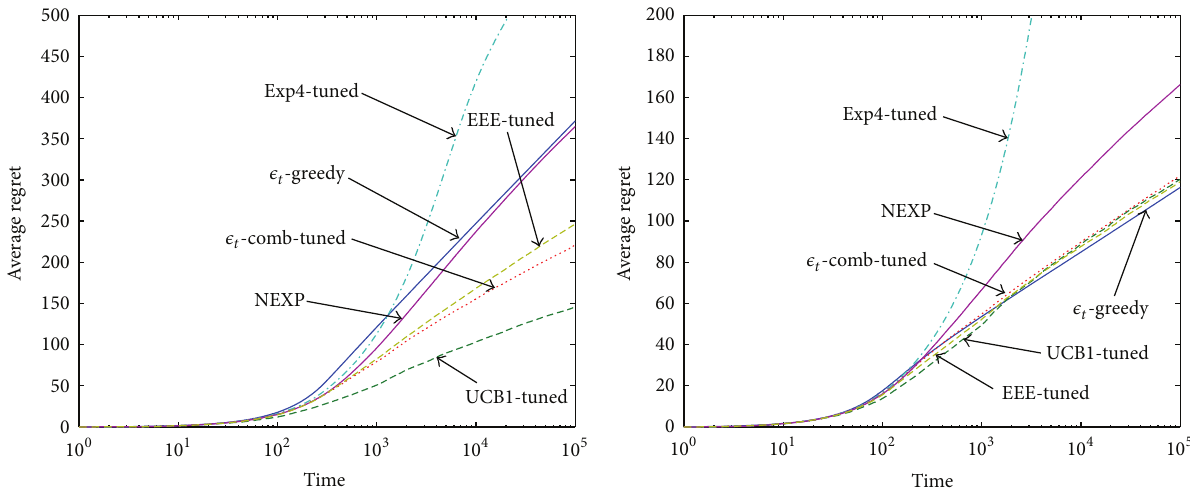
Figure 4: Average regret of tuned 𝜖 𝑡 -comb( {𝜖 𝑡 -greedy, UCB1-tuned } ) and of tuned Exp4 for the distributions of (0.9,0.8,0.8,0.8,0.7,0.7,0.7, 0.6,0.6,0.6) and